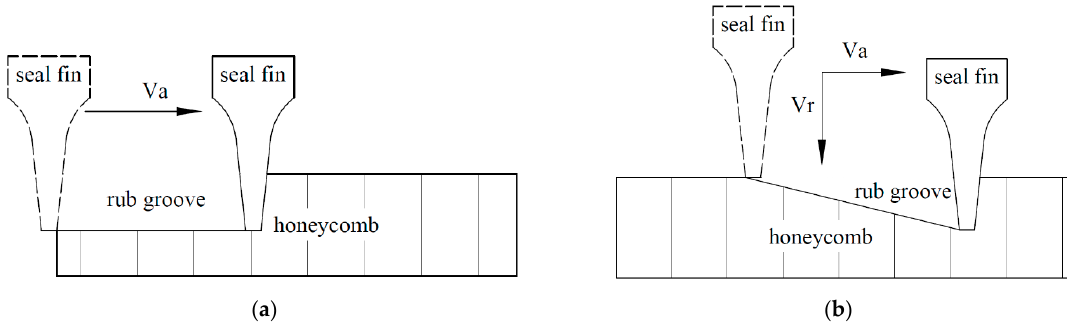
Figure 1. ( a ) The rubbing form in [17]; ( b ) the rubbing form in this paper. (V a : axial incursion rate; V r : radial incursion rate).